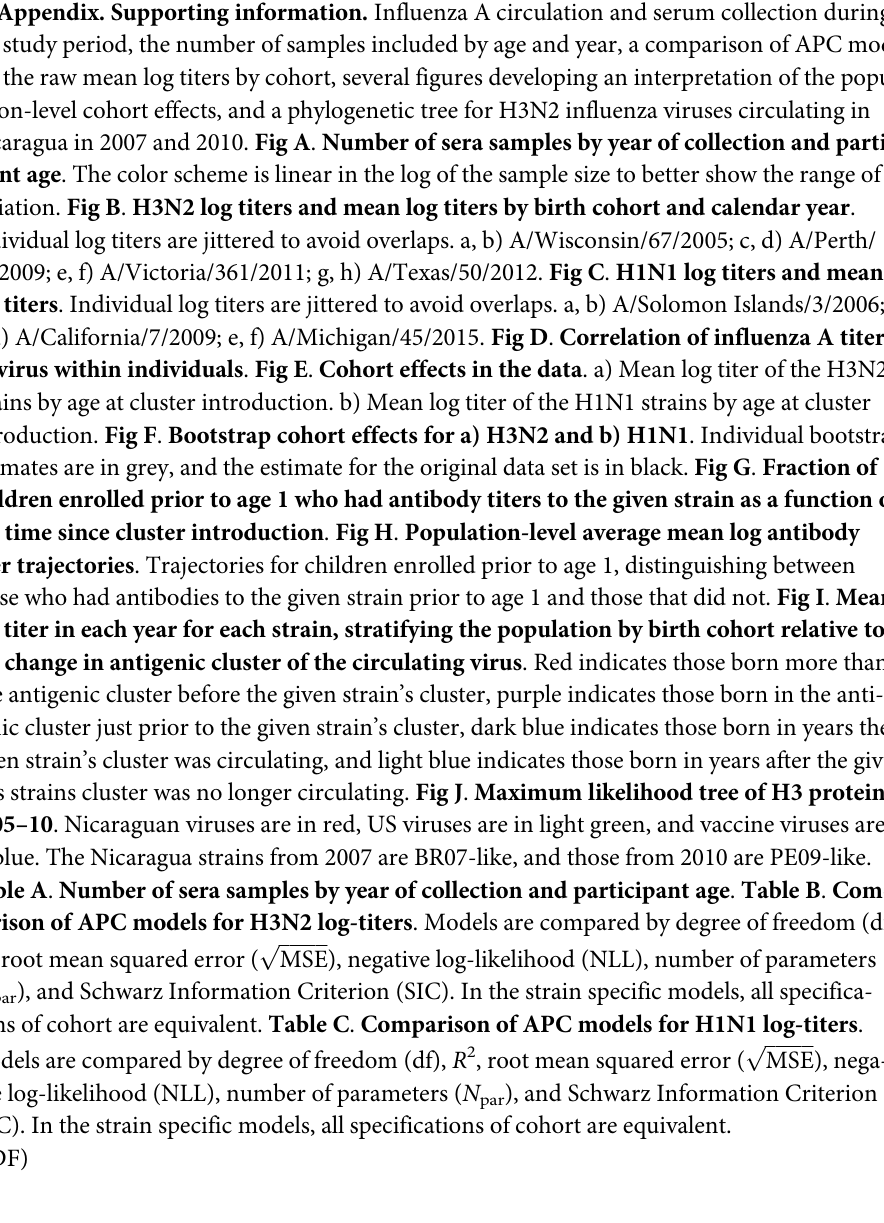
Table A . Number of sera samples by year of collection and participant age . Table B . Com- parison of APC models for H3N2 log-titers . Models are compared by degree of freedom (df), ffiffiffiffiffiffiffiffiffiffi p ), negative log-likelihood (NLL), number of parameters R 2 , root mean squared error ( MSE ), and Schwarz Information Criterion (SIC). In the strain specific models, all specifica- ( N par tions of cohort are equivalent. Table C . Comparison of APC models for H1N1 log-titers . ffiffiffiffiffiffiffiffiffiffi p Models are compared by degree of freedom (df), R 2 , root mean squared error ( ), nega- MSE tive log-likelihood (NLL), number of parameters ( N ), and Schwarz Information Criterion par (SIC). In the strain specific models, all specifications of cohort are